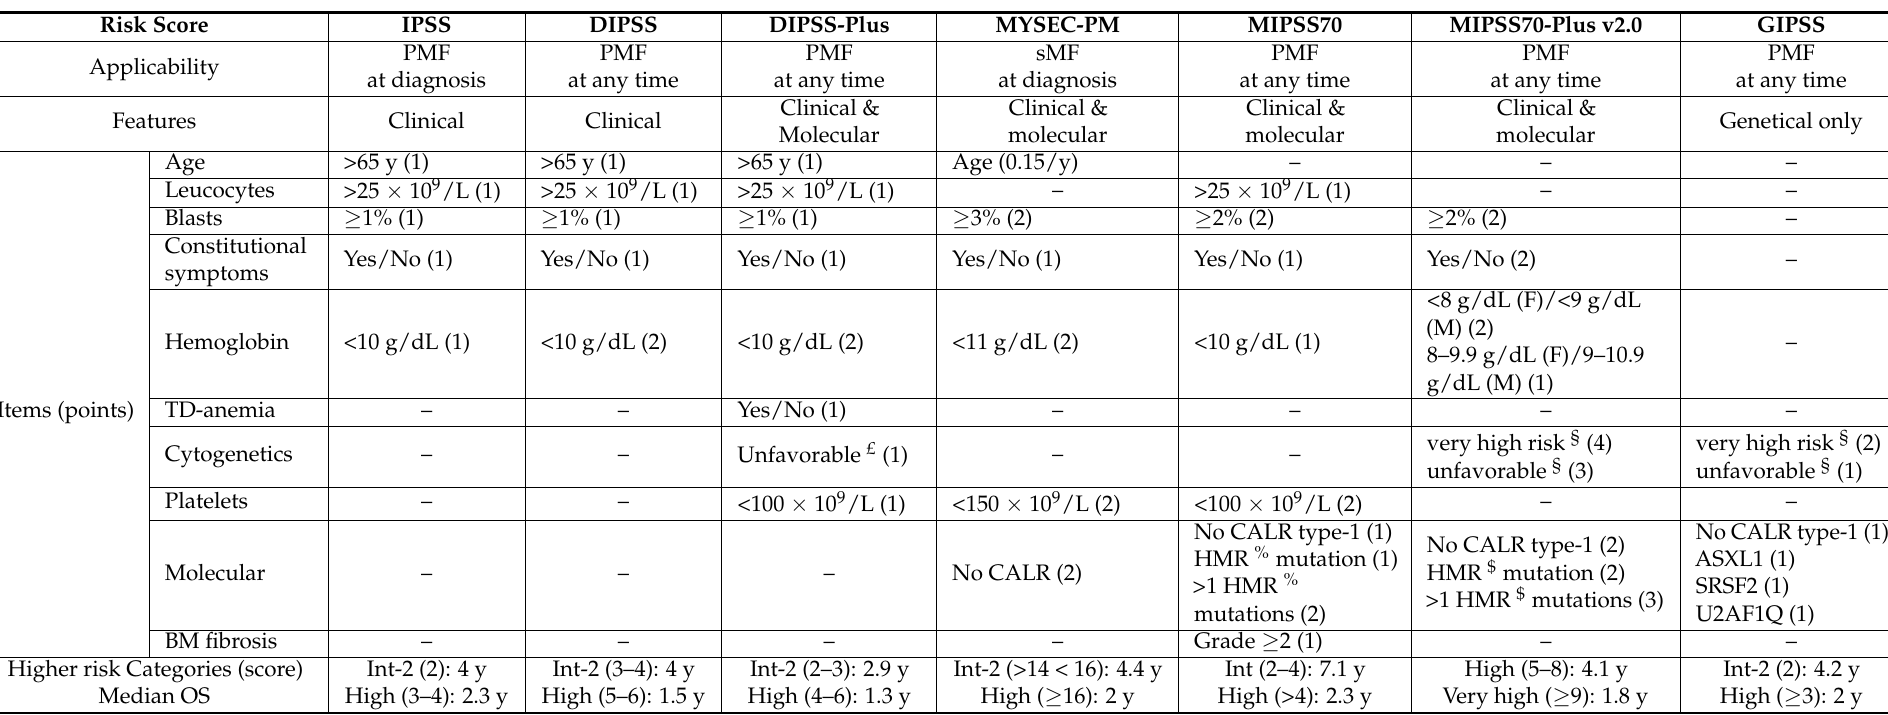
Table 1. List of the available risk score for MF and their prognostic relevance. PMF: Primary Myelofibrosis; sMF: Secondary Myelofibrosis; HMR: high molecular risk; Int: intermediate; TD transfusion-dependent; BM: bone marrow; OS: overall